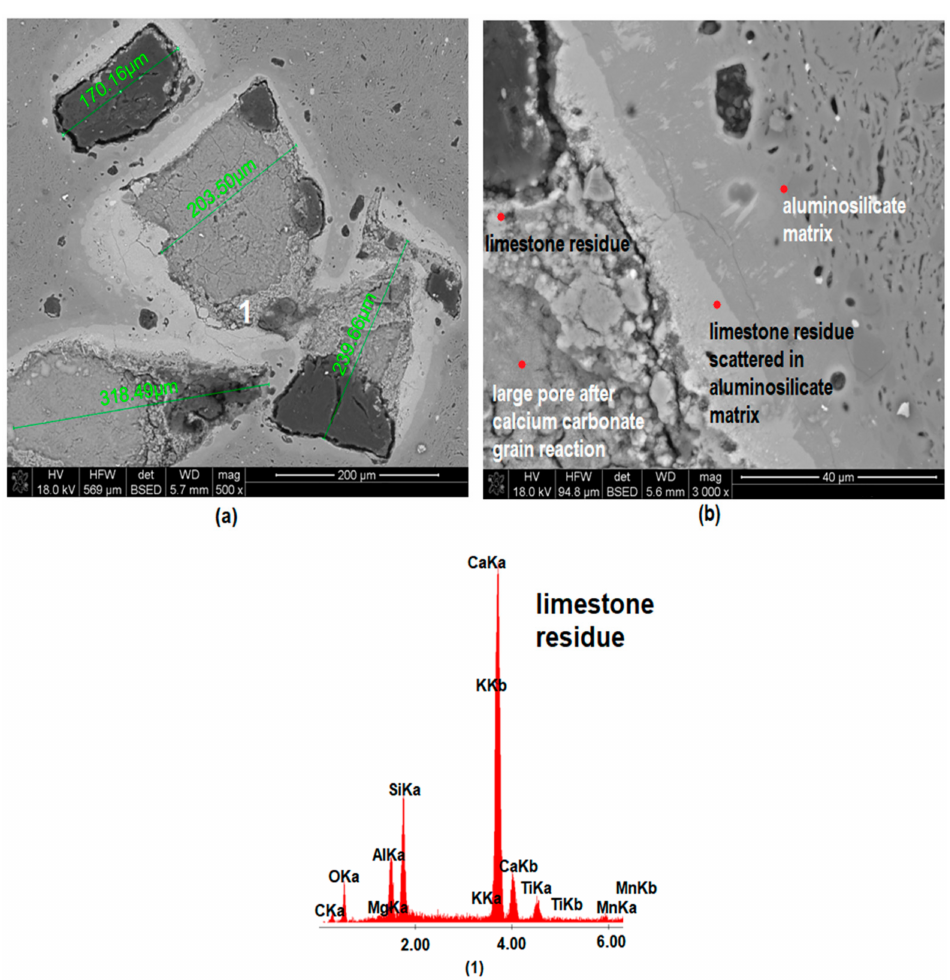
Figure 10. SEM-EDS image of MB306 material fired at 1160 ◦ C, including measurement of the size of pores resulting from the decomposition of calcium carbonate with ( a ) × 500 magnification and ( b ) × 3000